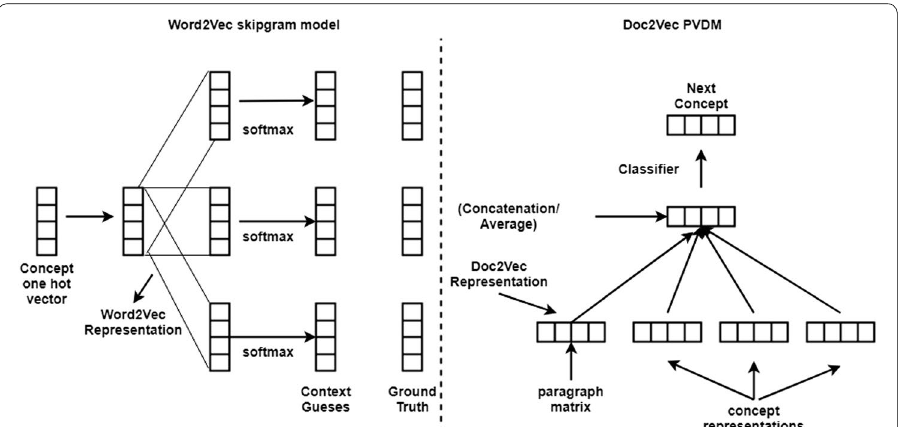
Fig. 8 Word2Vec skipgram architecture versus Doc2Vec PVDM architecture